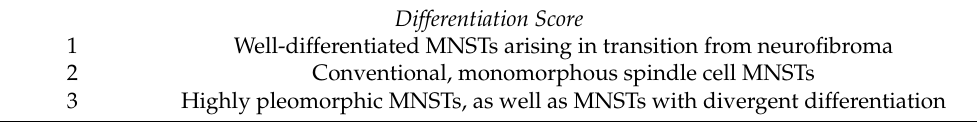
Table 1. Grading system for STS modified for